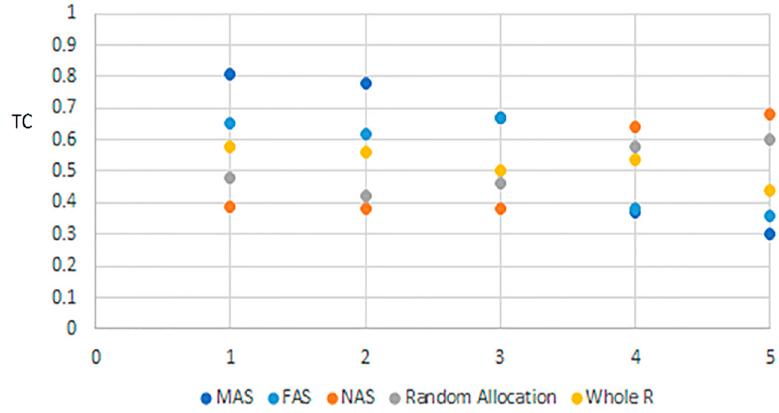
Figure 8. Problem 1, TC minimization in percentage over all scenarios in [7].